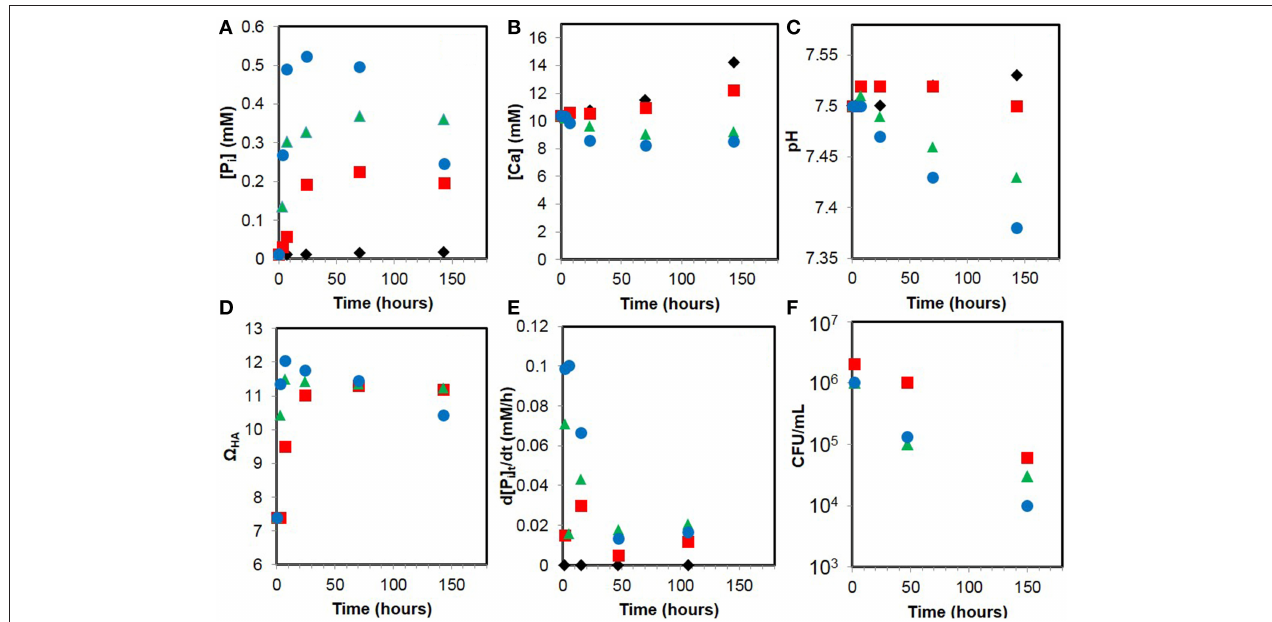
FIGURE 10 | Evolution of geochemical parameters during the calcification experiments with WT E. coli cells (red squares), AP1 (green triangles), APm1 (blue dots), and abiotic control (black diamonds). (A) Dissolved inorganic phosphate. (B) Dissolved calcium. (C) pH. (D) Supersaturation with respect to hydroxyapatite ( (cid:127) HA ). (E) Phosphate release rate (d[P i ] t /dt). (F) Viable cell counts